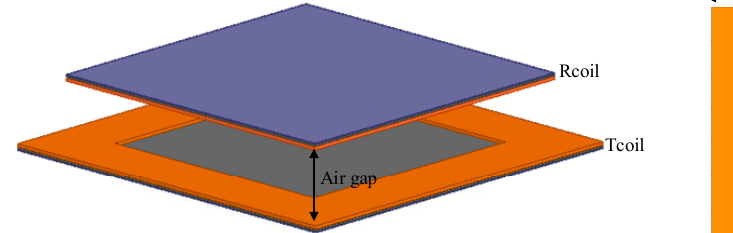
Figure 2. Schematic diagram of the laying of the transmitting coil of the expressway.